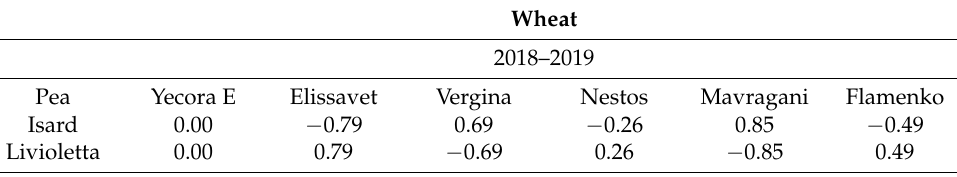
Table 7. Specific mixing ability (SMA) of wheat and pea varieties for the two growing